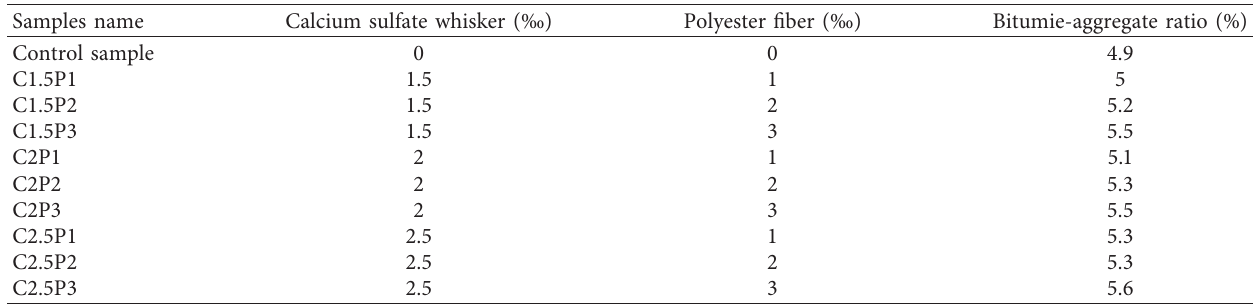
Table 5: Optimum bitumie-aggregate ratio with different